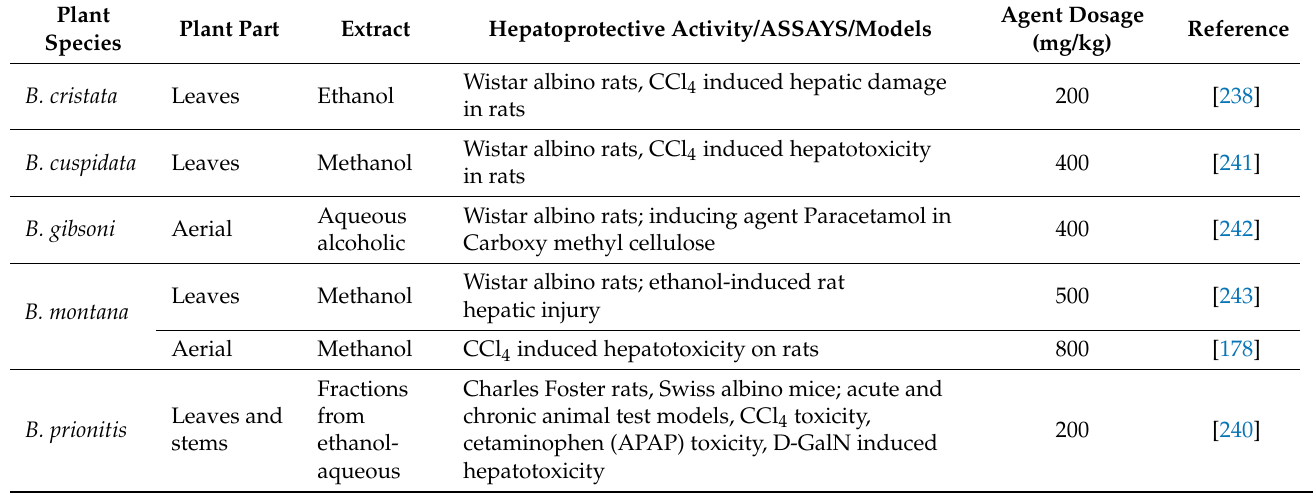
Table 9. Hepatoprotective activities of extracts and fractions from species within Barleria